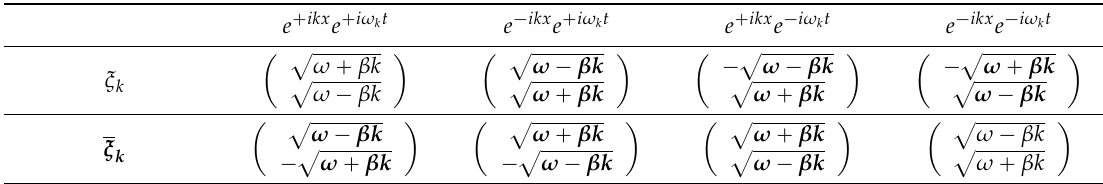
Table 1. Two by one spinor solutions of Equation (6a,b) for the different plane wave forms.